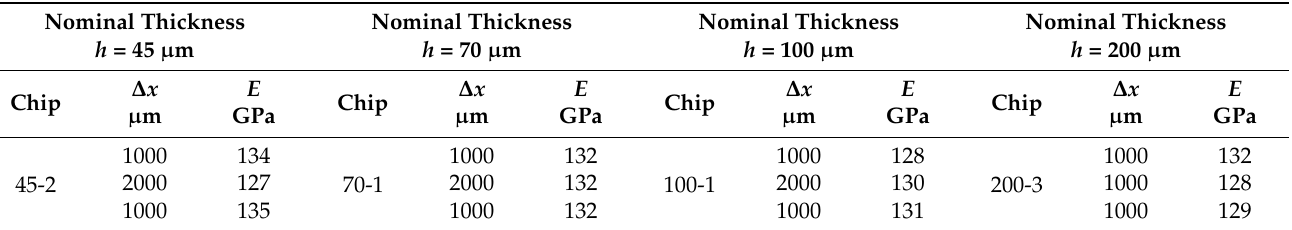
Table 4. Young’s modulus E calculated from the dimensions h , b and the measured stiffnesses c using the difference method ( E <100> = 130 GPa is the nominal